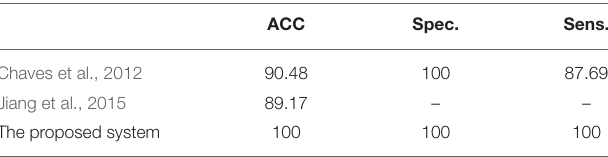
( Table 3 ) with a maximum performance of 100% of